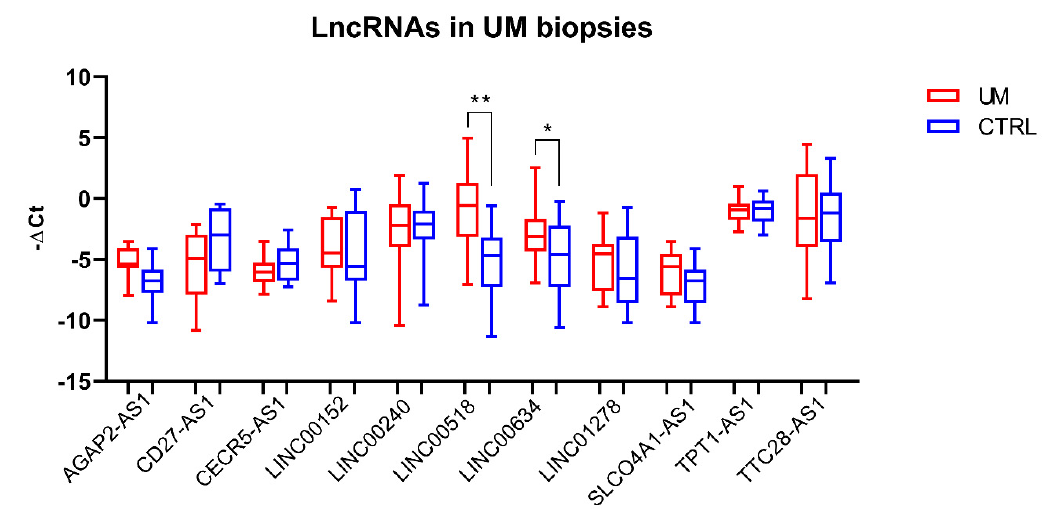
Figure 1. LncRNA expression analysis in tissue biopsies. Analysis was performed through Real-Time PCR in 41 pairs of tumor and normal tissues. *: p -value < 0.05; **: p -value < 0.0001.